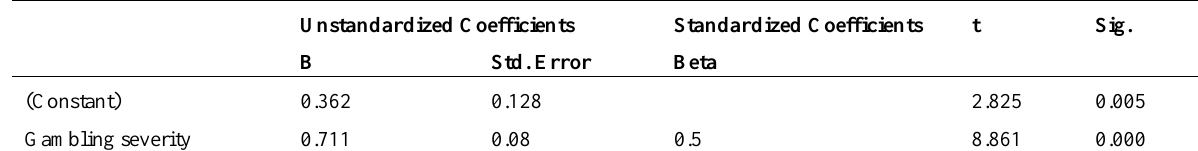
Table 8: Coefficients of Regression for Gambling Severity and Economic Wellbeing